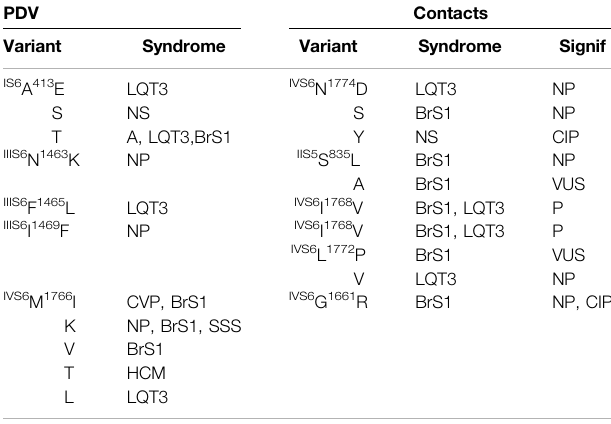
TABLE 3 | PDVs and their contact variants in the closed-PD model a